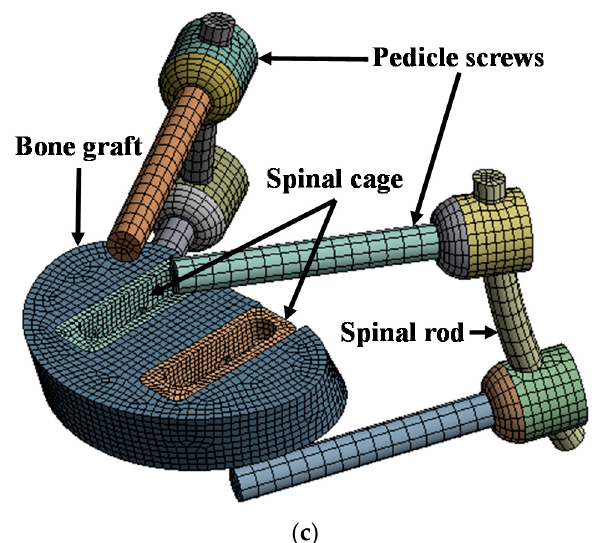
Figure 1. Finite element (FE) model of lumbar spine and spinal implants: ( a ) isometric view of FE model of lumbar spine and spinal implants; ( b ) rear view of FE model of lumbar spine and spinal implants; ( c ) isometric view of spinal implants.